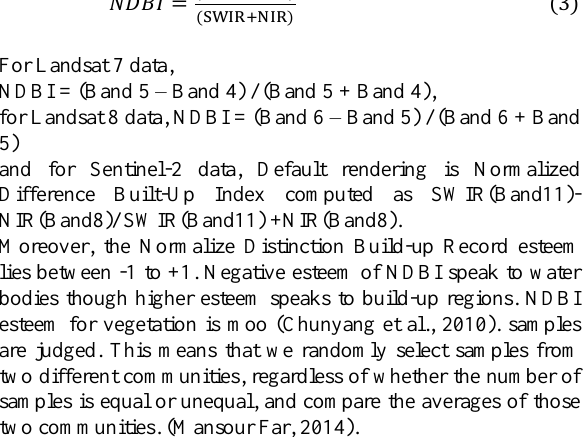
Figure 2. Research